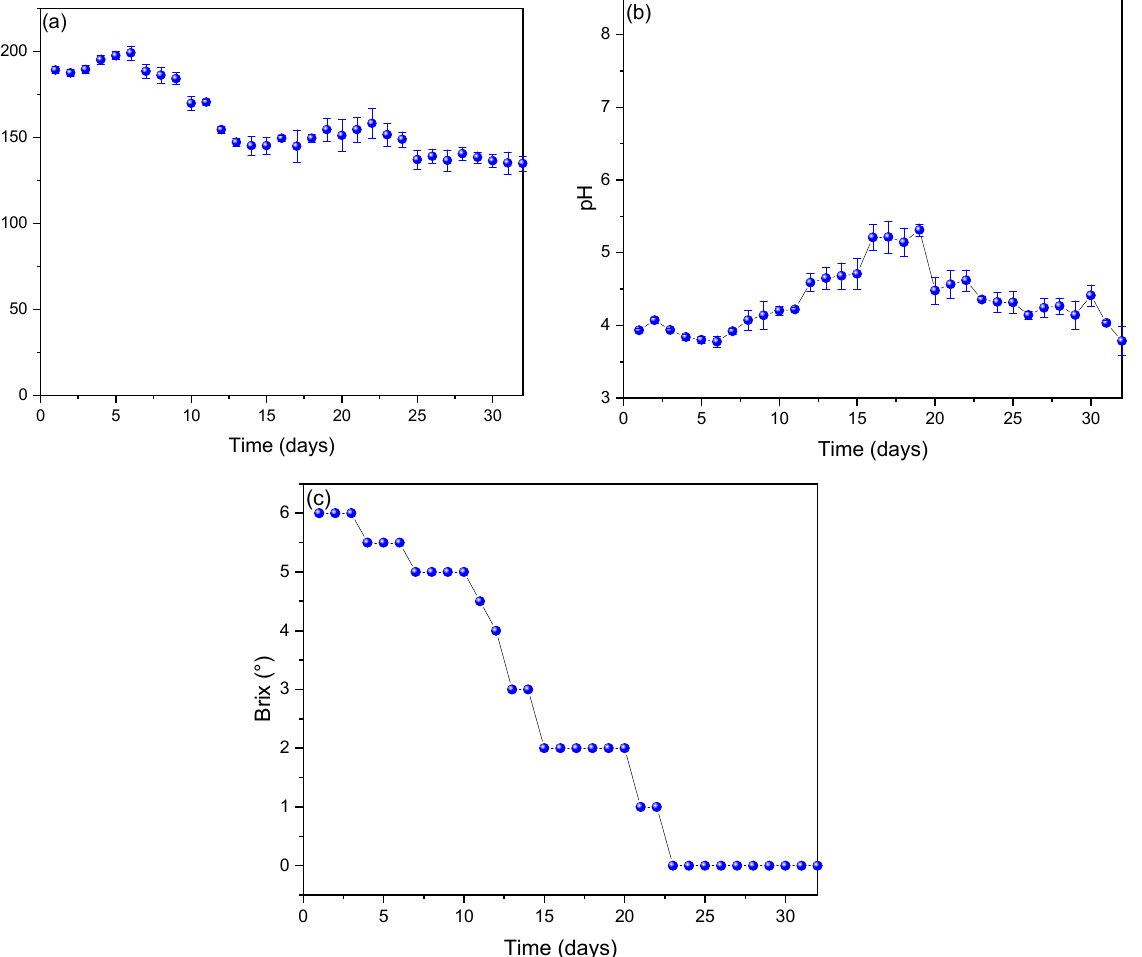
◦ Brix parameters of MFCs. Figure 2. Monitoring of ( a ) conductivity, ( b ) pH, and ( c ) °Brix parameters of MFCs. Figure 2. Monitoring of ( a ) conductivity, ( b ) pH, and ( c ) Figure 3a shows the value of the internal resistance of the microbial fuel cells, which are governed by Ohm’s Law (V = RI). The X axis represents the electrical current values (I) and the Y axis the voltage values (V), whose the linear fit slope would represent the average internal resistance (R int. ) of the MFCs. The R int. found was 865,845 ± 47.23 Ω in the MFCs; these values were found on day 20 because it was the day that generated the most intense electrical current values. Compared with other investigations, the values found for the R int. are high, but the values of current and voltage are higher than those found by other investigations; for example, Rashid et al. (2021), in their research, managed to generate 330 mV and 2.75 mA using single-chamber MFCs with graphite electrodes and pharmaceutical effluents with 99 Ω internal resistance [51]. Likewise, Liu et al. (2020) investigated the use of electrogenic bacteria as substrates and carbon electrodes in MFCs, managing to generate peaks of 0.63 V in the internal resistance of 162.9 ± 3.5 Ω